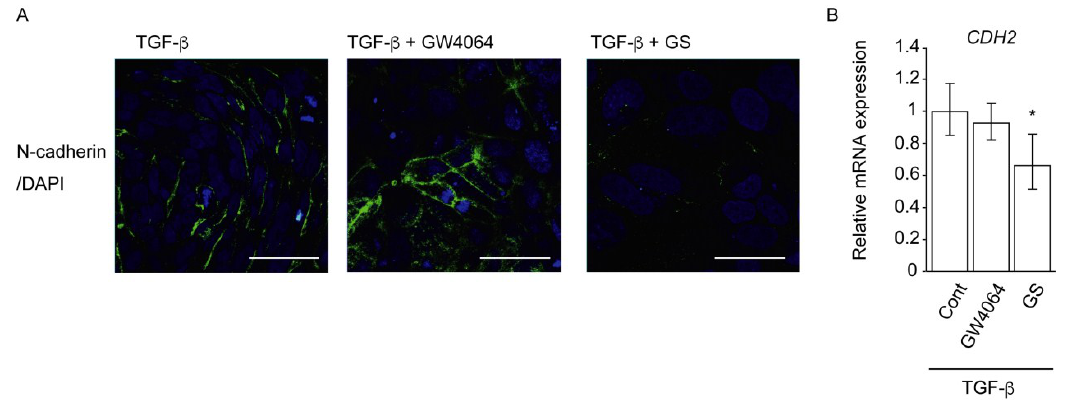
Figure 5. Combined effects of TGF-β and GW4064 or GS on N-cadherin expression in HuH-7 cells. ( A ) N-cadherin protein expression ( green ); and ( B ) CDH2 mRNA expression. Cells were treated with vehicle control (Cont), 10 μM GW4064, or 32 μM GS in the absence or presence of 10 ng/mL TGF-β for 48 h. Scale bar, 50 μm. * p < 0.05 versus Cont.